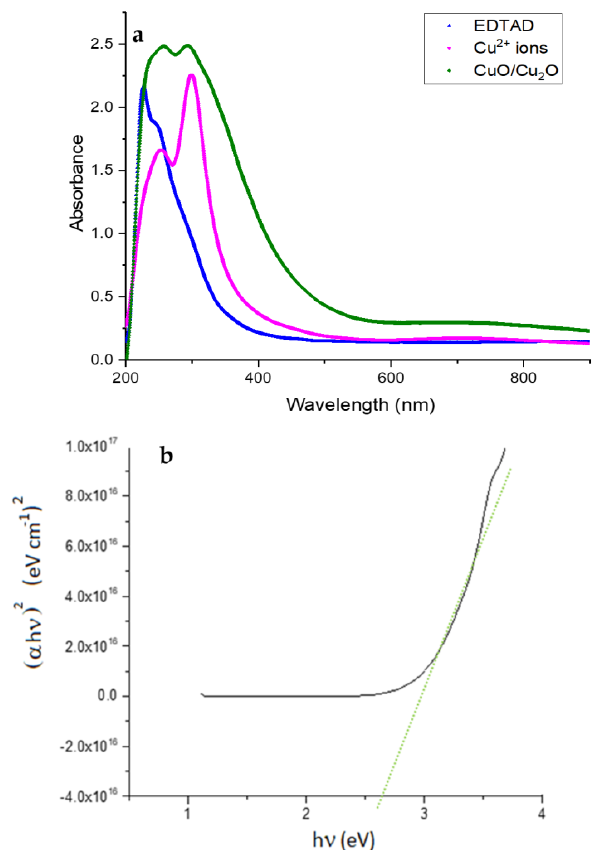
Figure 4. ( a ) UV spectra of every step of modification of NAM and ( b ) Tauc plot for NAM- CuO/Cu 2